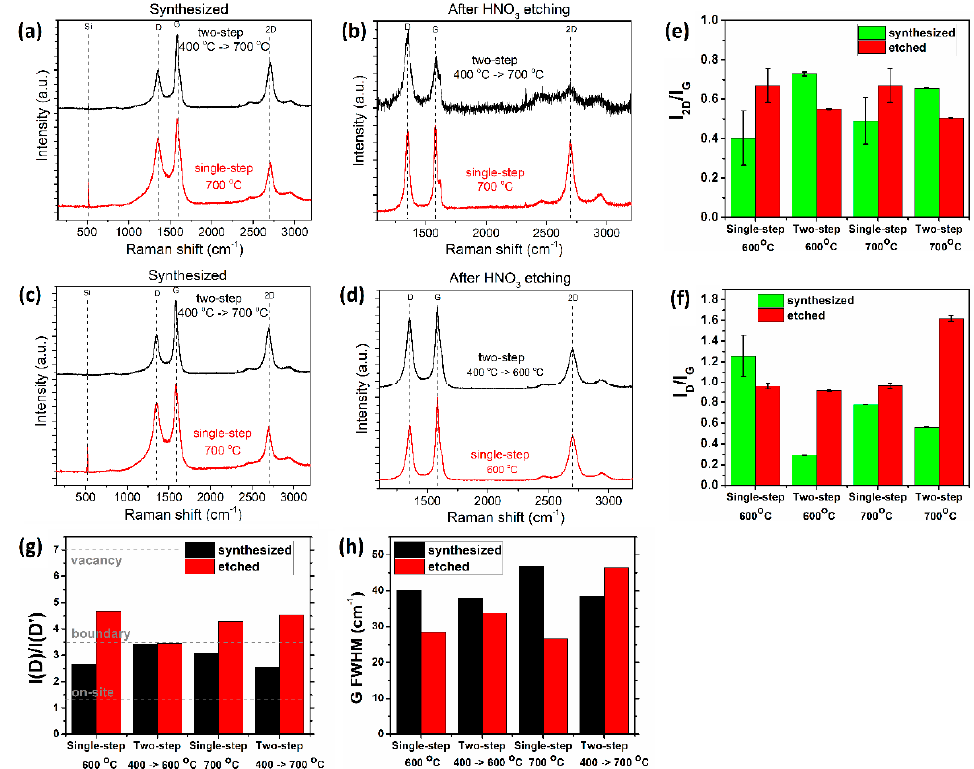
Figure 8. The comparison of the structure of graphene grown by a single step and a two-step synthesis: the Raman spectra after the synthesis ( a , c ) and after removing the sacrificial cobalt interlayer ( b , d ); Raman spectra parameters analyzed: I 2D /I G ( e ); I D /I G ( f ); I D /I D’ ( g ); FWHM(G) ( h ); optical microscopy photos of the sample annealed at 500 °C temperature before ( g ) and after the etching ( h ). Co layer thickness was 25 nm, ion beam energy—800 eV, ion ‐ beam treatment time—15 min.